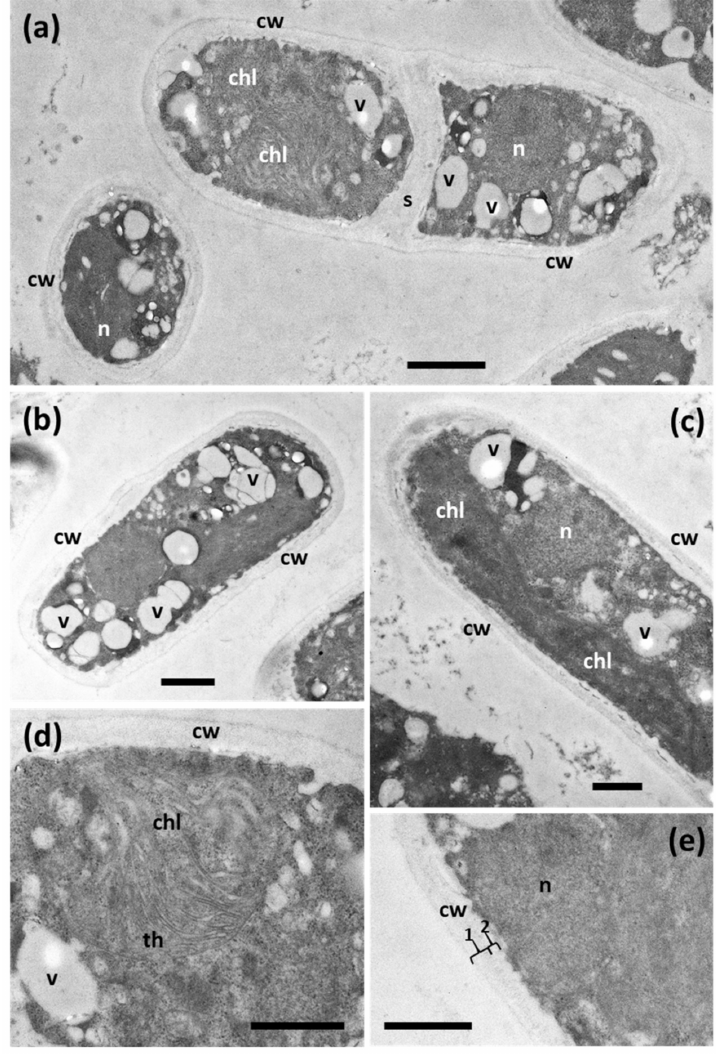
Figure 1. Diplosphaera elongata sp. nov. ultrastructural features found using TEM growing in solid BBM at 18 ◦ C: ( a ) D. elongata cells—on the right, a cell cross-section, and on the left, a longitudinal section of a divided cell; ( b ) single rod-shaped cell; ( c ) chloroplast situated in a longitudinal position close to the cell wall; ( d ) detail of the chloroplast and thylakoids; ( e ) detail of the cell wall showing two layers (1,2). Abbreviations: chl (chloroplast), cw (cell wall), n (nucleous), s (septum), th (thylakoid), v (vesicles). Scalebars: ( a ) = 1 µ m, ( b ) = 800 nm, ( c – e ) = 600 nm. Reference strain: ASUV